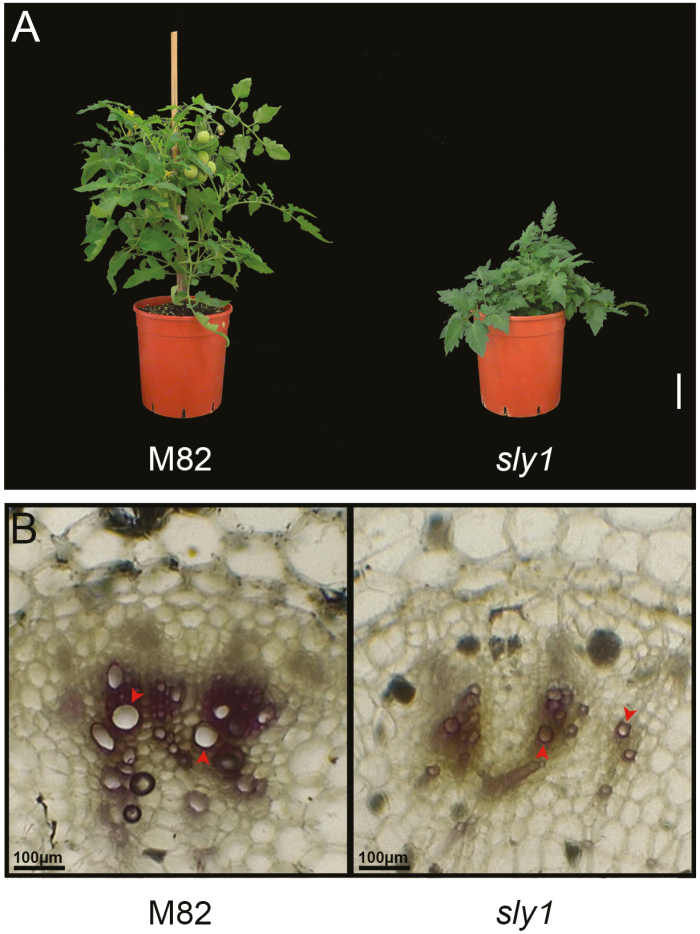
Loss of SlSLY1 suppressed xylem vessel proliferation and expansion. (A) Two-month-old M82 and representative CRISPR-Cas9-derived sly1 mutant. Scale bar: 3 cm. (B) Representative petiole cross sections of M82 and sly1 stained with Wiesner stain. sly1 and M82 petioles with similar diameter (the mutant leaves were much older) were microscopically analysed. Scale bar: 100 μm.